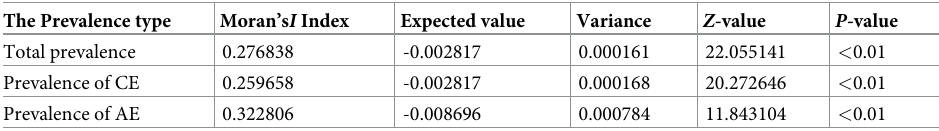
and sheep are mainly slaughtered in families, stray dogs are present in high number and are fed with Echinococcus- infected remains [19,20]. Dogs are definitive hosts for E . granulosus senso lato and E . multilocularis in China [8,21]. E . granulosus senso lato and E . multilocularis have different intermediate hosts [21]. Echinococcus parasites need two mammalian hosts to complete their life cycle [7]. Transmission of E . granulosus s . l . occurs between dogs and live- stock, while E . multilocularis transmission occurs between stray dogs or foxes as definitive hosts and rodents as intermediate hosts [21]. Humans are aberrant intermediate hosts and they are infected by ingesting E . multilocularis eggs [22]. The involvement of wildlife in E . mul- tilocularis transmission cycle is not clear and further researches are needed to investigate this issue. However, the spatial distribution of the prevalence of human echinococcosis directly reflects the range and degree of the corresponding transmission cycle of CE and AE. It can thus guide prevention and control activities, such as strengthening the control of stray dogs in the epidemic areas of AE, carrying out control measures of intermediate host animal density and monitoring the infection status. Health education and people awareness should also be considered. According to the different epidemic degrees of CE and the local control capacity, the frequency of deworming should be determined to achieve the purpose of scientific guidance. There is a focal spatial distribution for echinococcosis infections, with defined areas at high risk for parasite transmission between definitive and intermediate hosts, where the prevalence or incidence of human echinococcosis may be higher than in surrounding areas [7]. Humans may be accidentally infected through food or water consumption. Dogs and livestocks can contaminate rivers and the environment [23–25]. The Buddhist doctrine applied by local